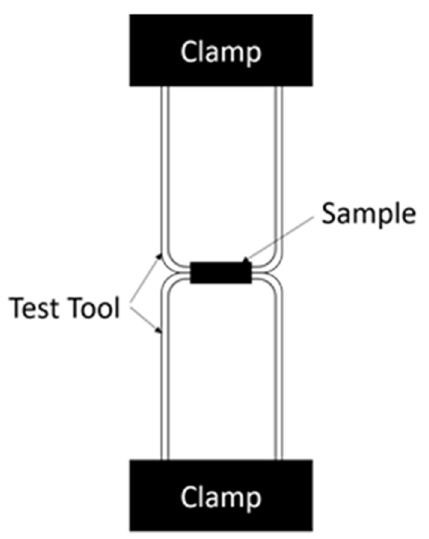
Figure 2. Schematic of the final test set-up with both wires inserted into the link-shaft sample, after which they are pulled in opposite directions to stretch the link-shaft in its radial direction.